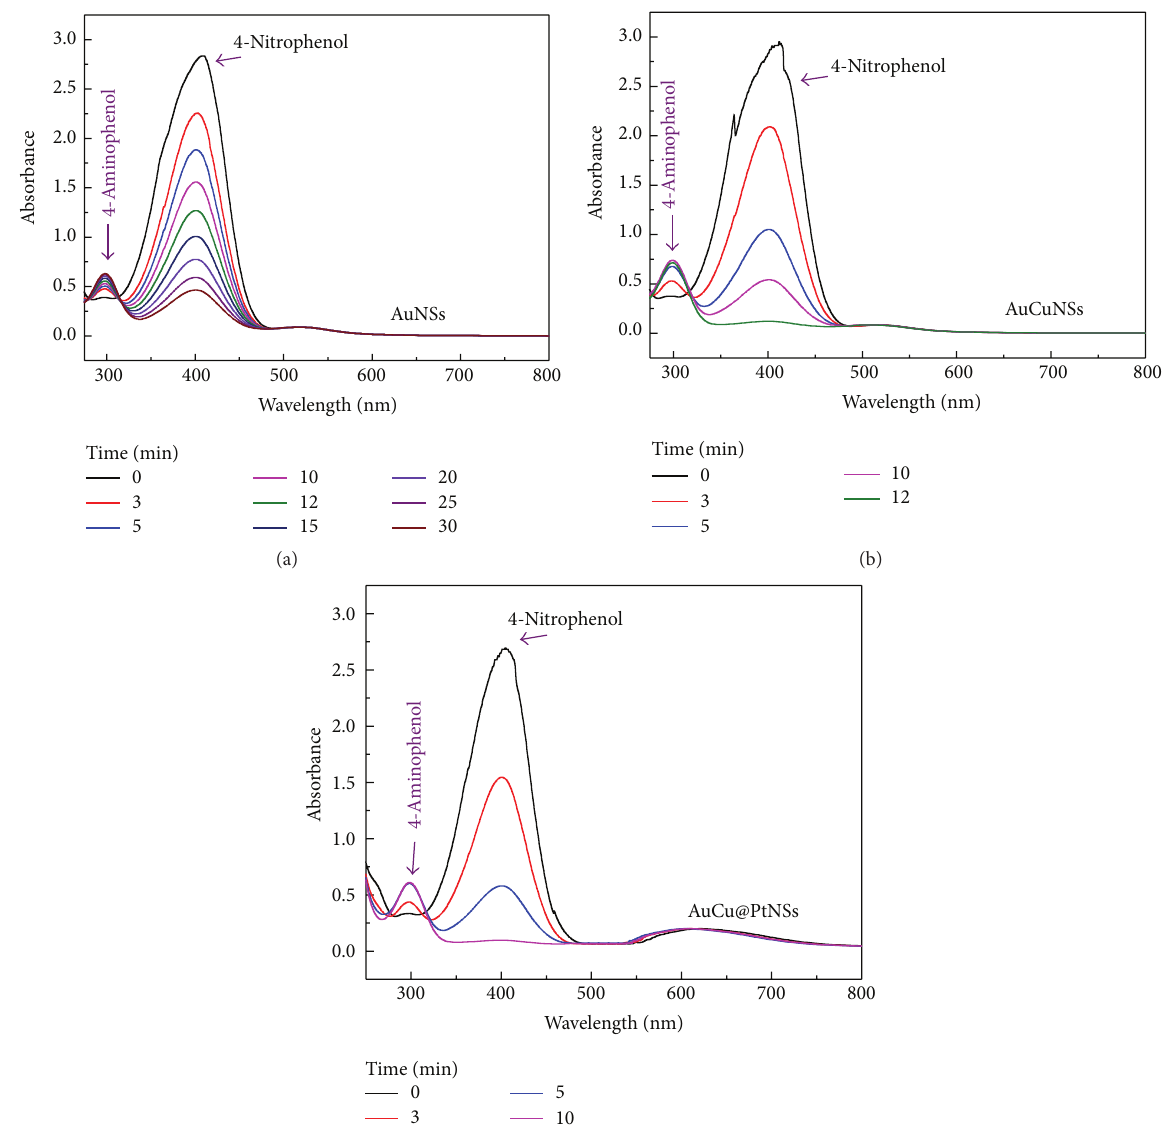
Figure 2: UV-visible spectra for catalytic reduction of 4-NP in the presence of AuNSs (a), AuCuNSs (b), and AuCu@PtNS